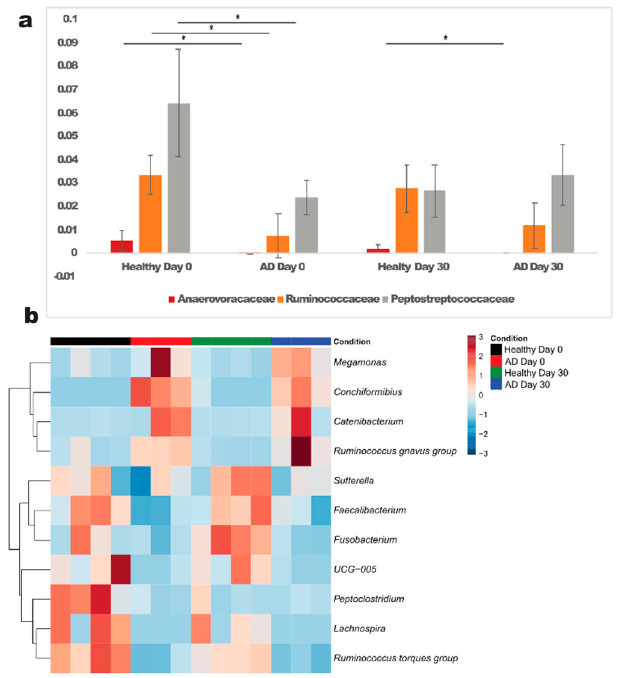
Figure 3. Significantly different families ( a ) and genera ( b ) in atopic and healthy dogs at day 0. *—significant differences were detected between healthy and atopic dogs ( p < 0.05); AD—atopic dogs